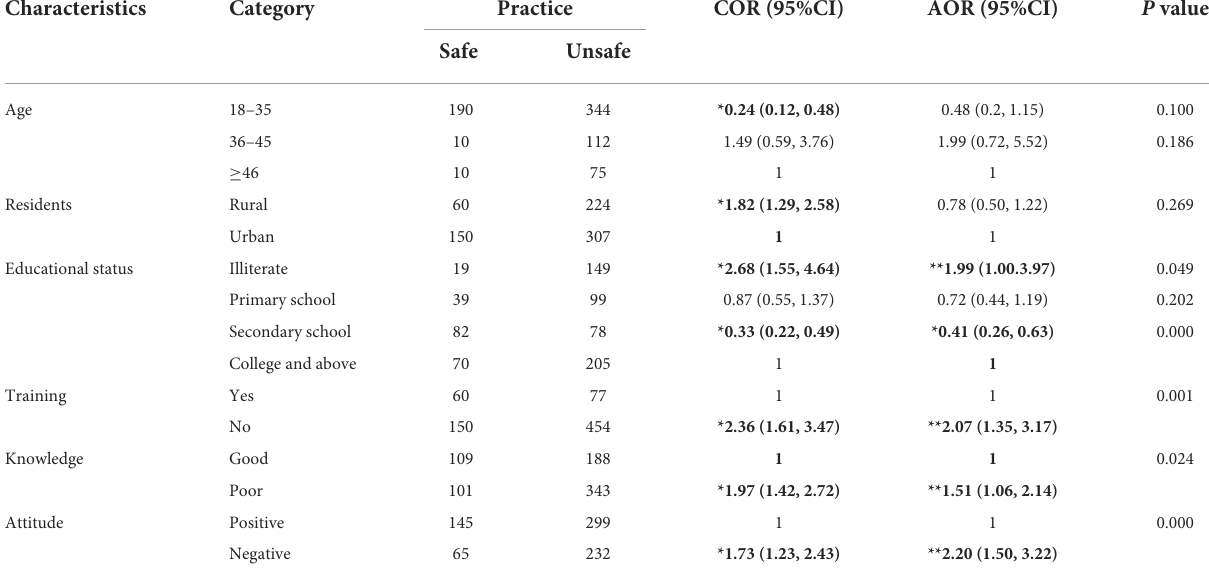
TABLE 2 Factors associated with public first aid practice measures of an epileptic seizure, Northwest Ethiopia, 2021 ( n = 741).